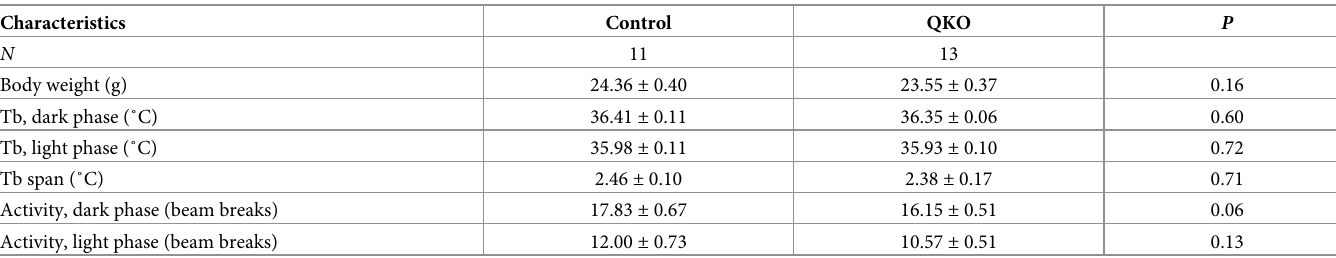
Table 2. Tb and physical activity in QKO and control mice.